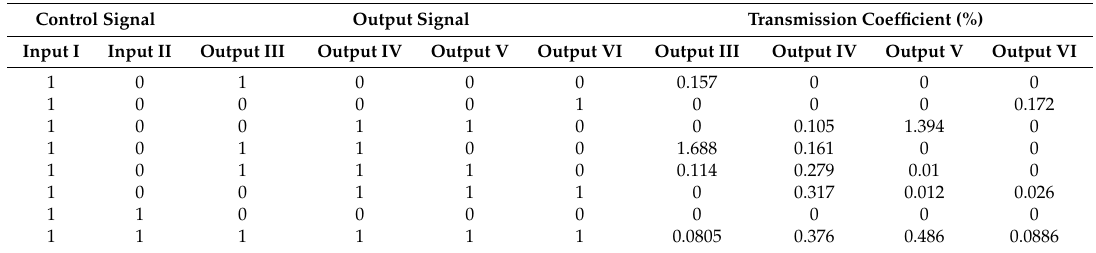
Table 5. Transmission coefficients of the two-input four-output switch at different logical states. Control Signal